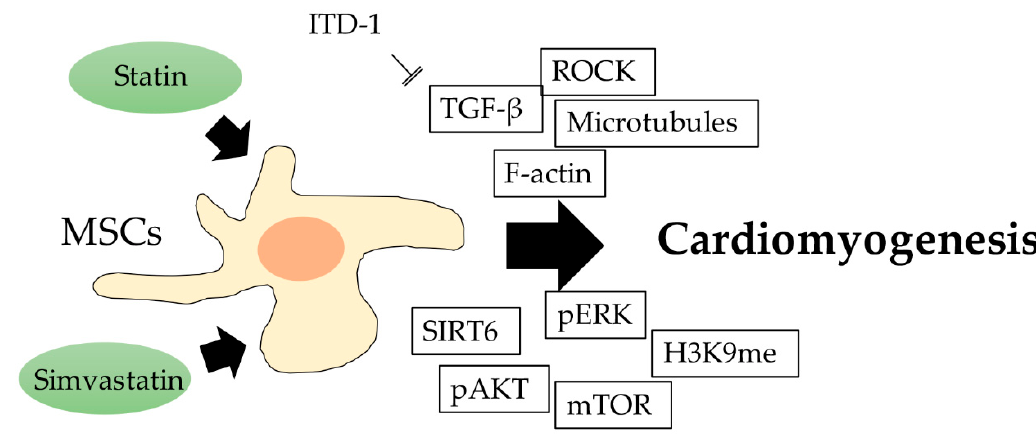
Figure 7. The schematic diagram showing lipid-lowering drug regulation of MSC cardiomyogenesis, Figure 7 The schematic diagram showing lipid ‐ lowering drug regulation of MSC cardiomyogenesis, and the potential involved and the potential involved molecules.